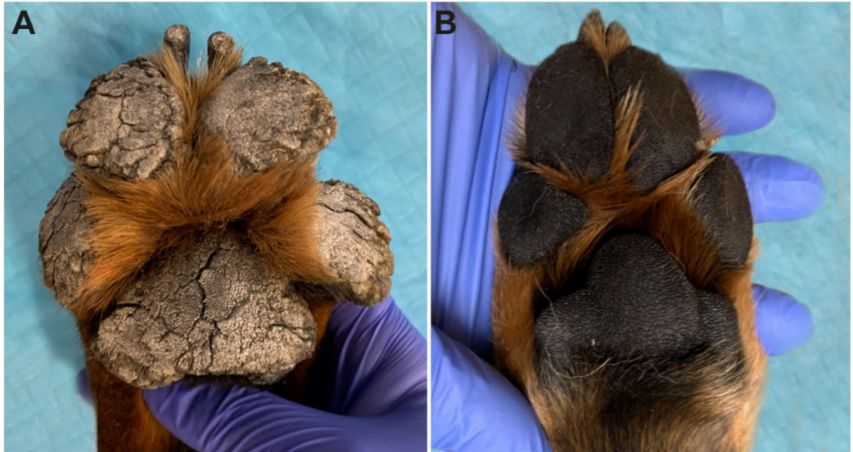
Figure 1. Clinical phenotype at six months of age. ( A ) Marked expansion of the footpads by thick projections of dense keratin in the a ff ected Rottweiler. The adjacent haired skin appears una ff ected on this image. ( B ) Footpads of a normal six-month-old control